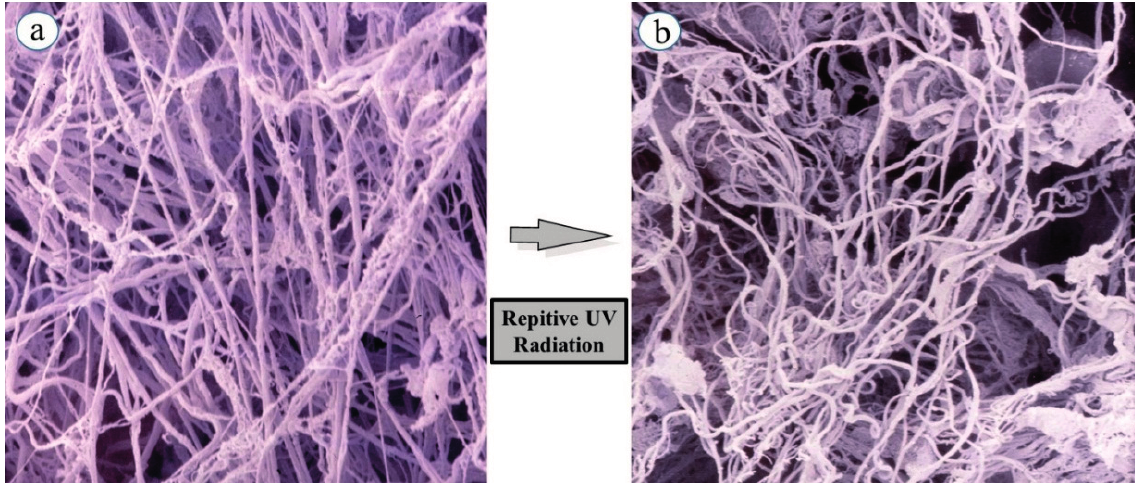
Figure 1. Curing of elastin fibers in a three-dimensional configuration following repetitive UVB exposure. ( a ) Elastic fibers in non-exposed skin; ( b ) Elastic fibers in repeatedly UVB exposed skin. Rats were placed in cages individually and irradiated by a bank of five Toshiba SE lamps (UVB) without any filtering. The UVB lights have no detectable emission below 340 nm and a peak of emission near 312 nm with the irradiance between 290 and 320 nm corresponding to 55% of the total amount of UVB. The distance from the UVB lamps to the animals’ hind limbs was 42 cm (irradiance approximately 0.72 mW/cm 2 ). UVB radiation at a dose of 130 mJ/cm 2 (rat 1 minimal erytyemal dose (MED) = 170 mJ/cm 2 ) was given three times weekly from three to eight weeks of